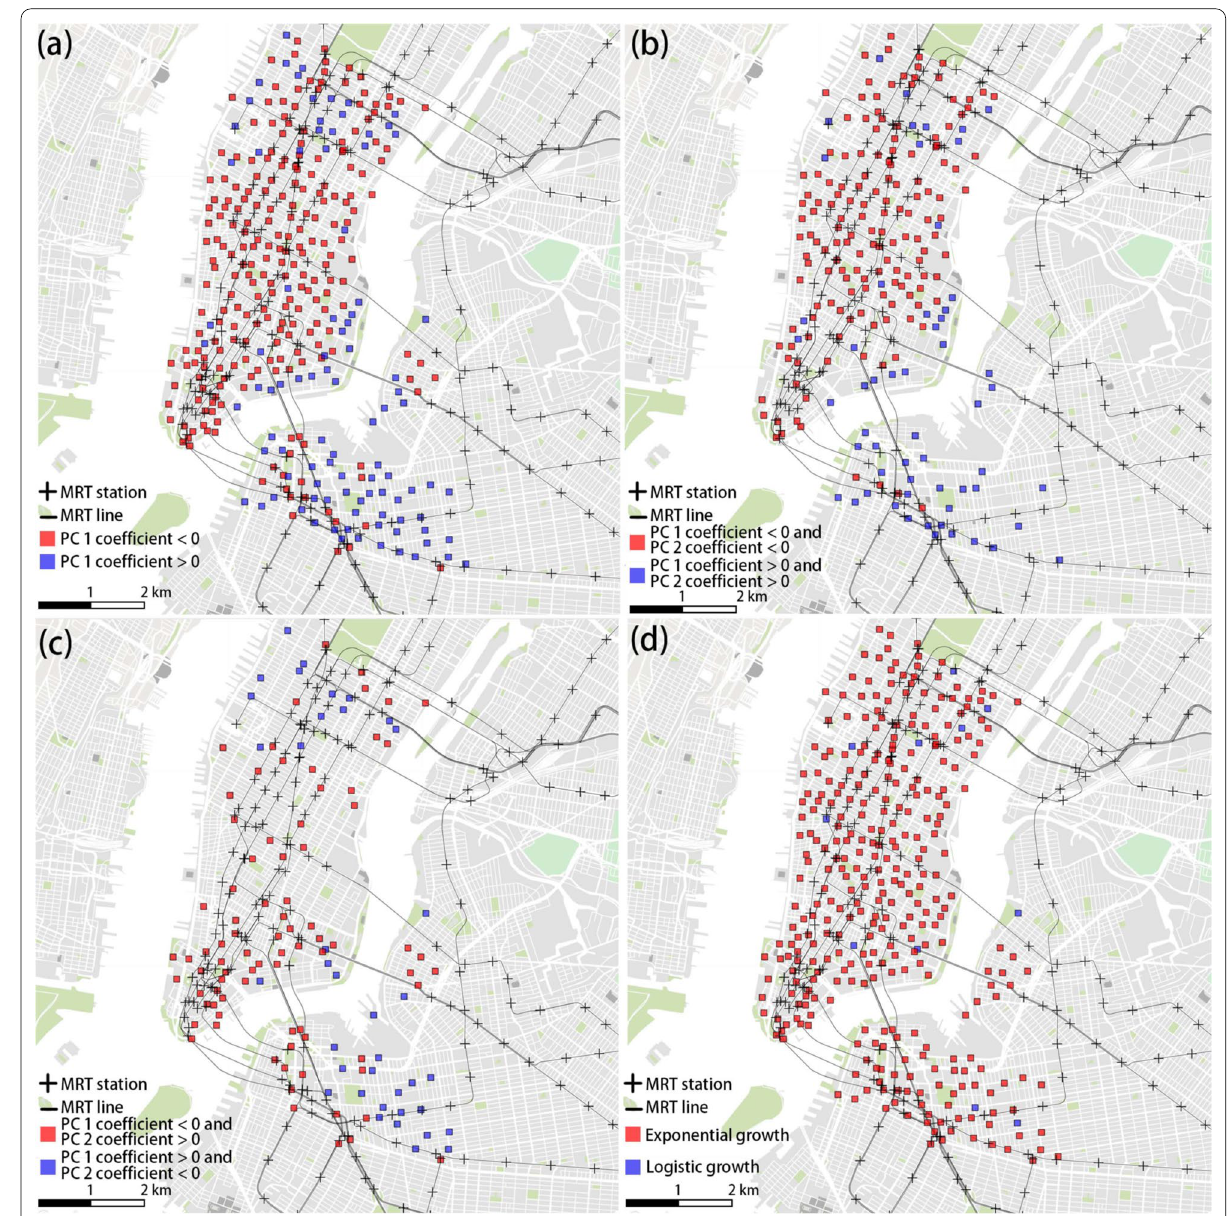
Fig. 12 Distinct spatial patterns of station growth. a Negative and positive PC 1. b . Negative PC 1 and PC 2, Positve PC 1 and PC2. c . Negative PC 1 and positive PC 2; positive PC 1 and negative PC 2. d Exponential and logistic